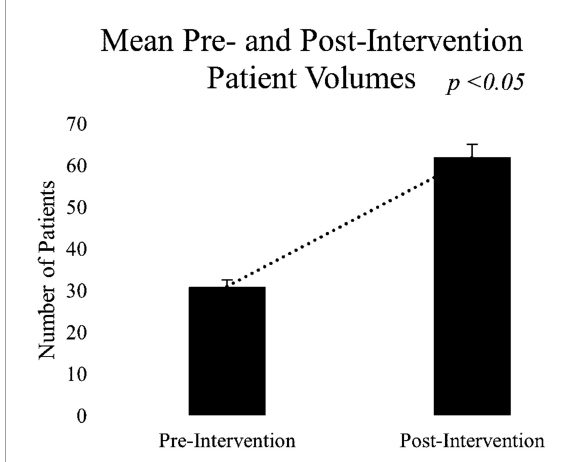
inappropriate referrals to the PRIT clinic declining over time (23% in Cycle 1 vs. 4% in Cycle 3).